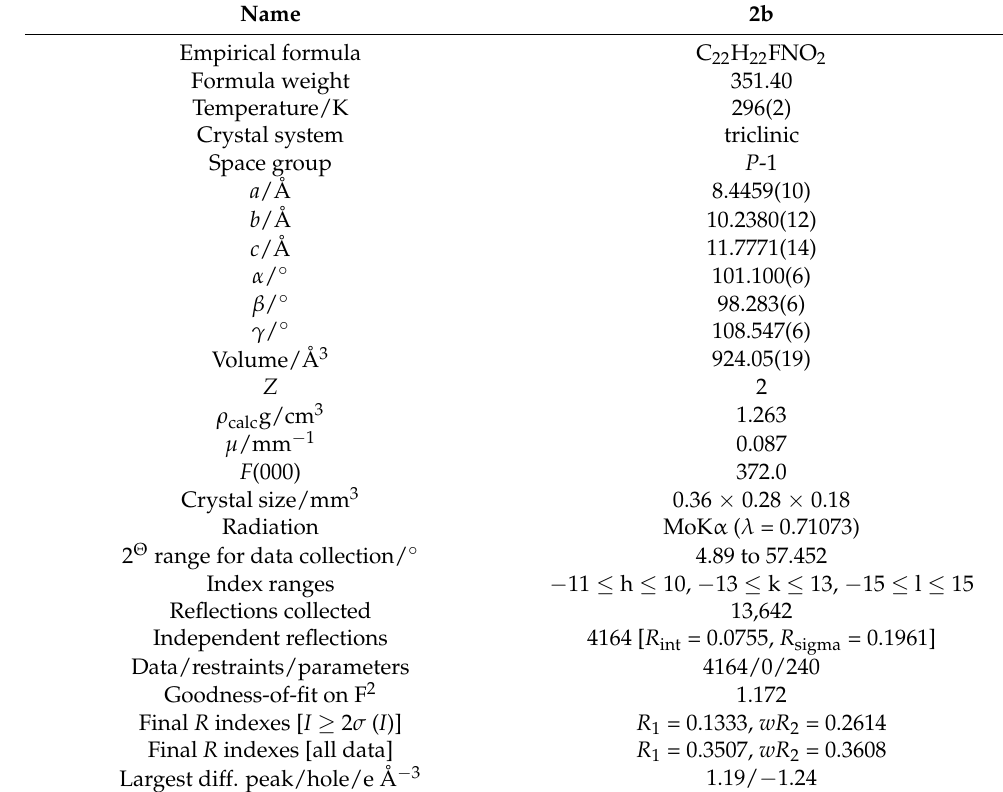
Table 2. Crystal data and structure refinement of compound 2b